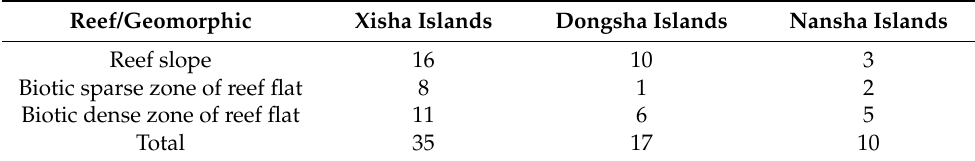
Table 2. Number of field sites used for modeling in geomorphic and reef flat ecological zones for the Xisha Islands, Dongsha Islands, and Nansha Islands.